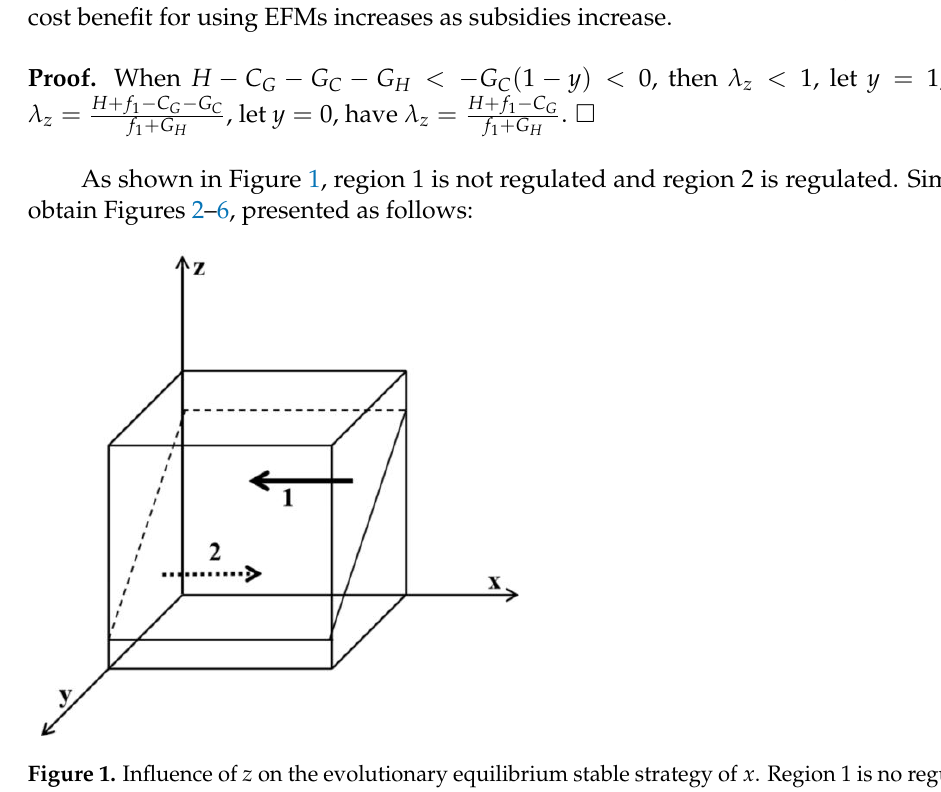
Figure 1. Influence of z on the evolutionary equilibrium stable strategy of x . Region 1 is no regulation; region 2 is regulation.